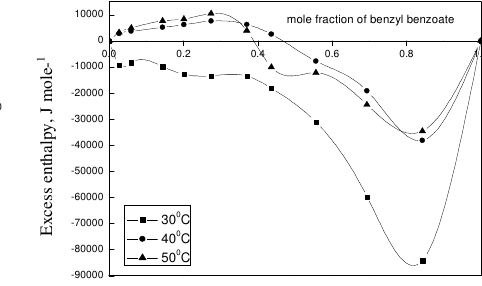
Figure 1a. Variation of excess adiabatic compressibility with mole fraction of benzyl benzoate in the mixture benzyl benzoate + acetonitrile